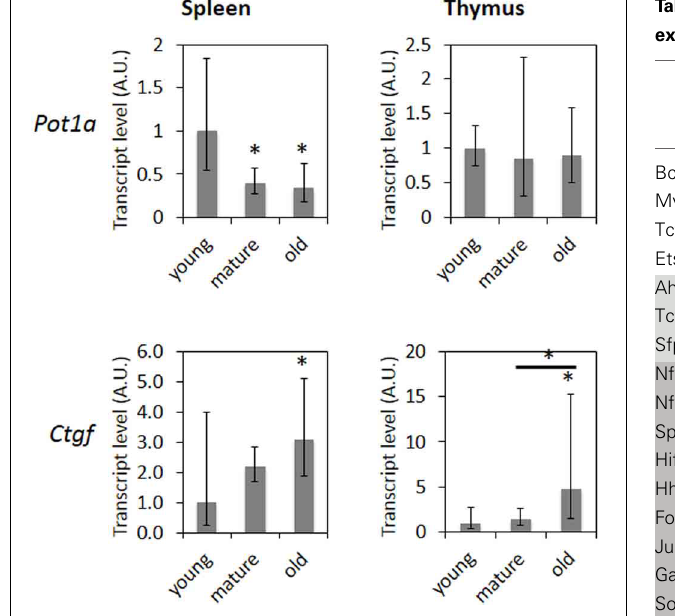
FIGURE 3 | mRNA levels of senescence-related genes in aging spleen and thymus. Bars represent averages from three animals and two technical repeats normalized to expression in young animals ± 95% confidence intervals. ∗ Indicates significance based on one-way ANOVA ( p < 0 . 05).